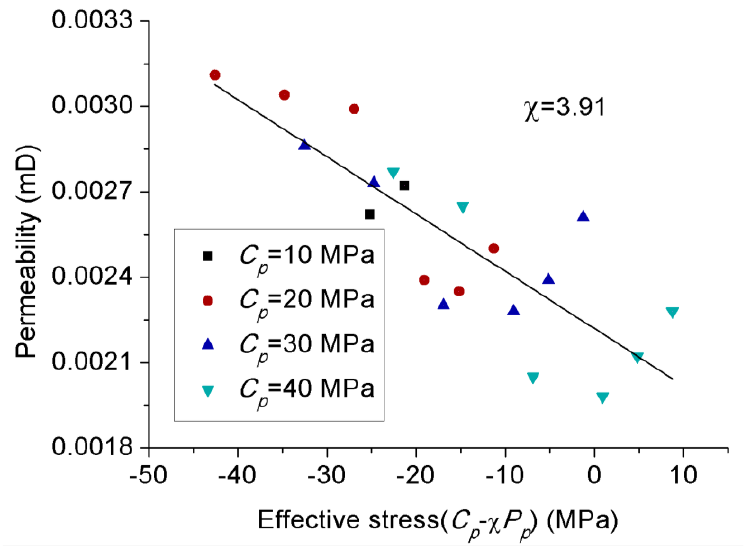
Figure 24. Permeability versus modified effective stress for liquid CO 2 state under steady-state conditions.